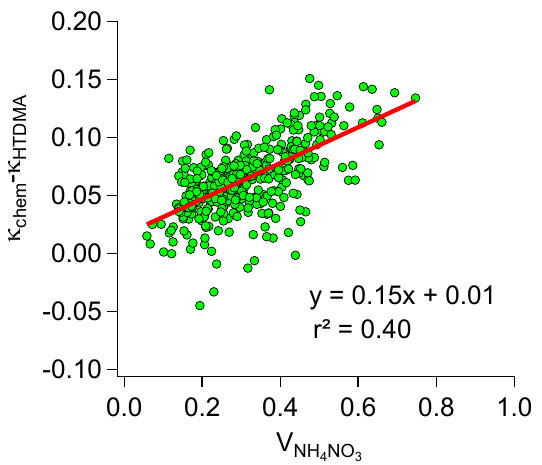
Fig. 6. Difference between κ chem and κ HTDMA as a function of vol- ume fraction of NH 4 NO 3 ( V NH Fig. 6: Difference between  chem and  HTDMA as a function of volume fraction of NH 4 NO 3 (V NH4NO3 ). 787